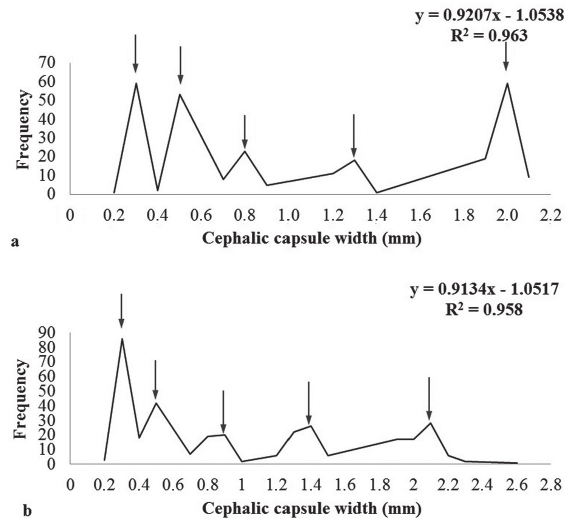
Figure 3 - Larval instars of Condylorrhiza vestigialis and the width of the cephalic capsule on natural diet ( a ) and artificial diet ( b ). Temperature 25 ± 2°C, RH 60 ± 10% and photophase of 14 h. Arrows indicate the instars.